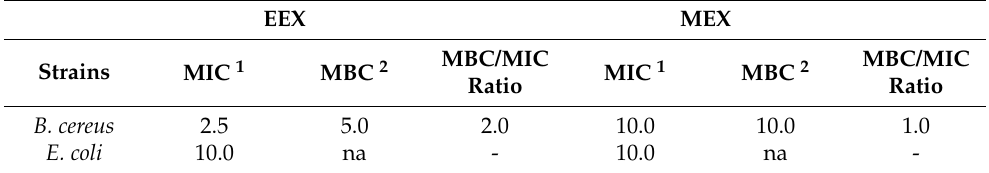
Table 6. Antibacterial activity of EEX and